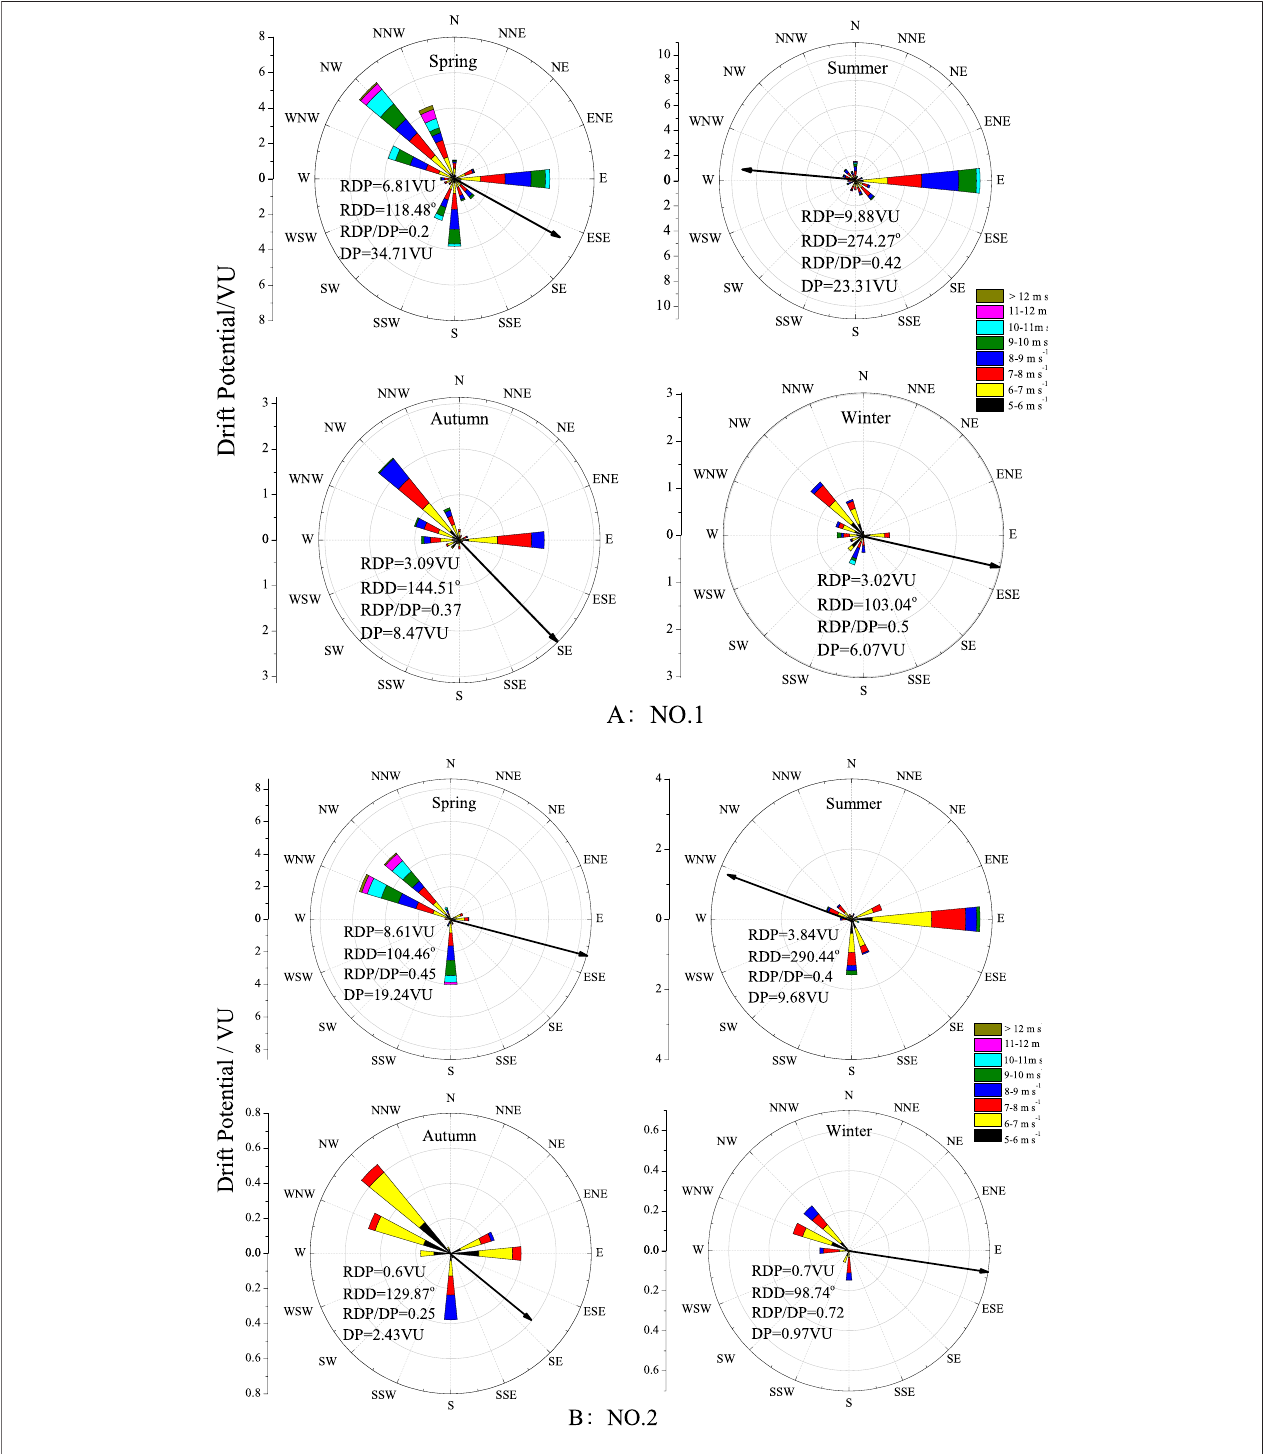
FIGURE 5 | Seasonal sand drift potential at No. 1 and No. 2 in 2018.